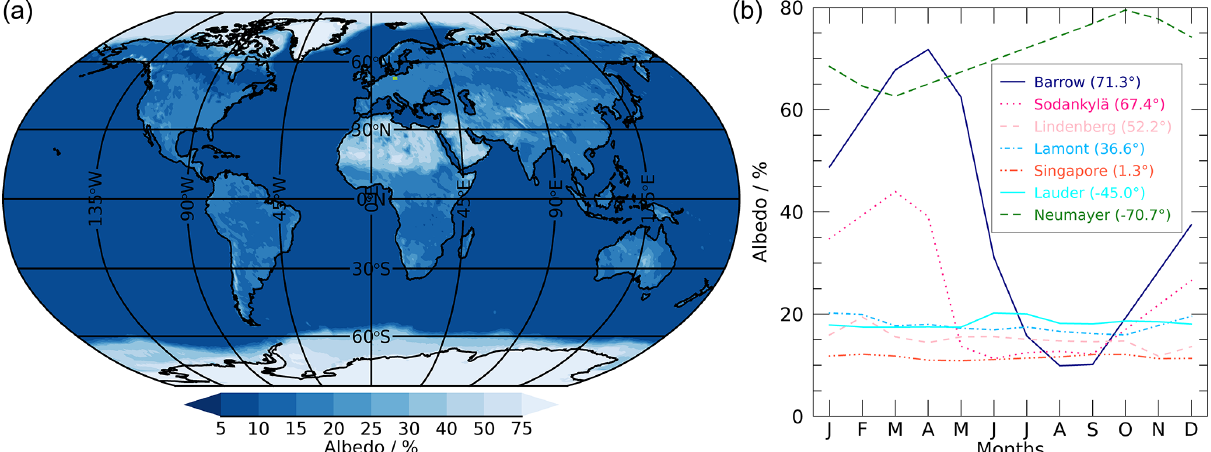
Figure 15. (a) Map of the monthly averaged global surface albedo between 0.25 and 2.5µm for the month of June, used for the processing of a radiosounding performed at Lindenberg on 11 June 2020, 12:00UTC. (b) Annual cycle of the monthly averaged albedo at GRUAN sites of various geographical latitudes.